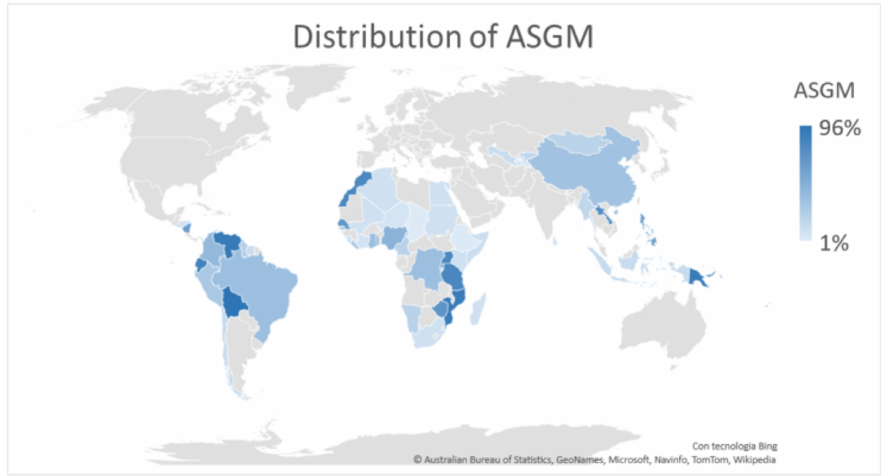
Figure 2. Level of ASGM for each country.